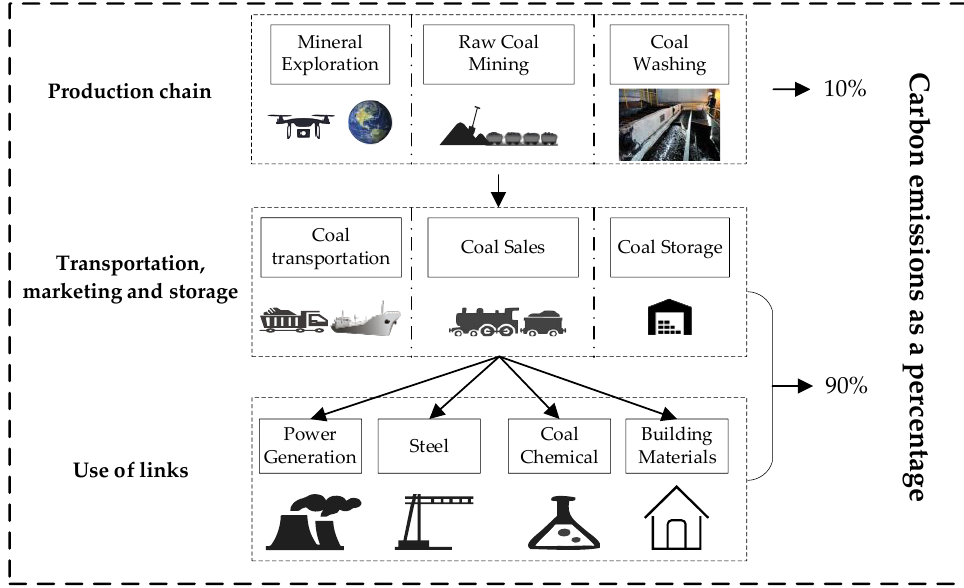
bon emission from coal transportation, sales, storage, and utilization accounts for nearly nearly 90% [4,16,17]. 90% [4,16,17].